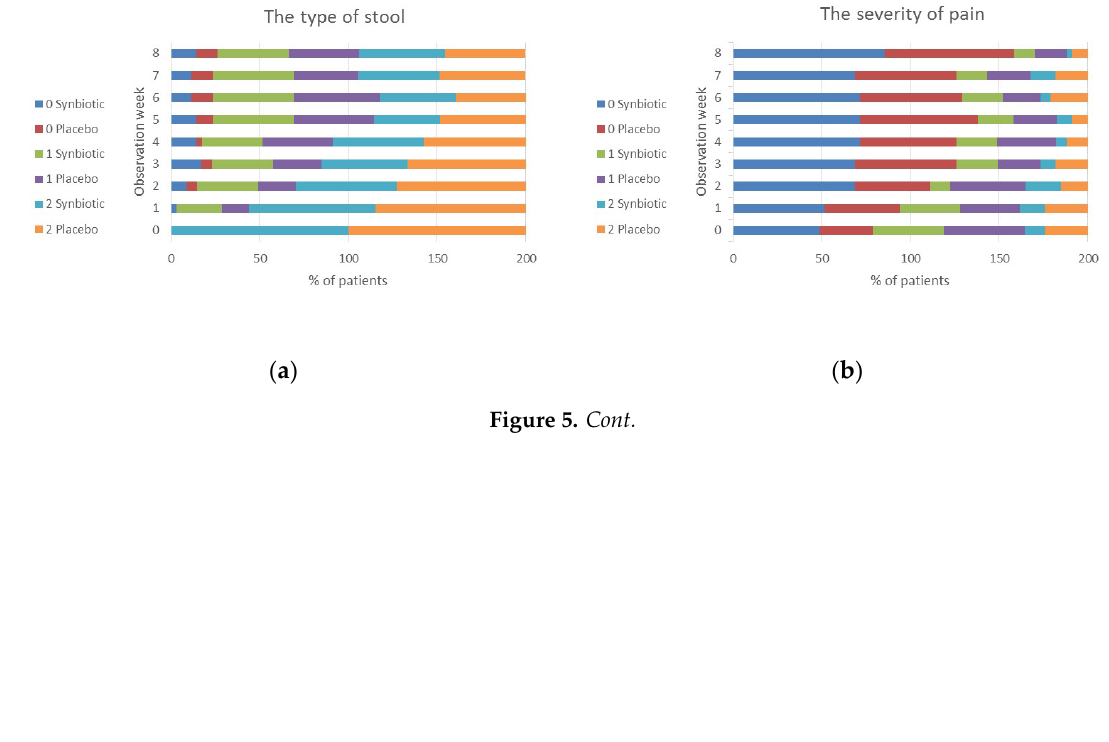
Figure 4. Weekly changes of IBS symptom scores of flatulence ( a ), abdominal pain ( b ), stool pressure ( c ), and a feeling of incomplete bowel movement ( d ) on a Likert scale (the lower the score the greater improvement). * Statistical significance between studied groups ( p < 0.0001).